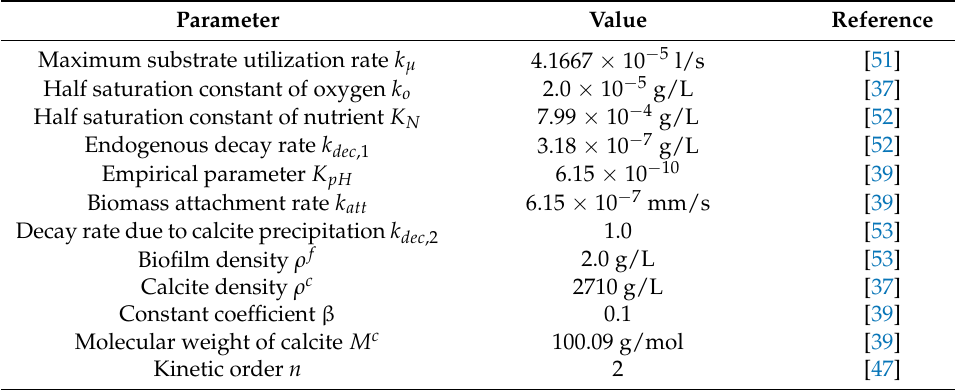
Table 1. Parameters in the